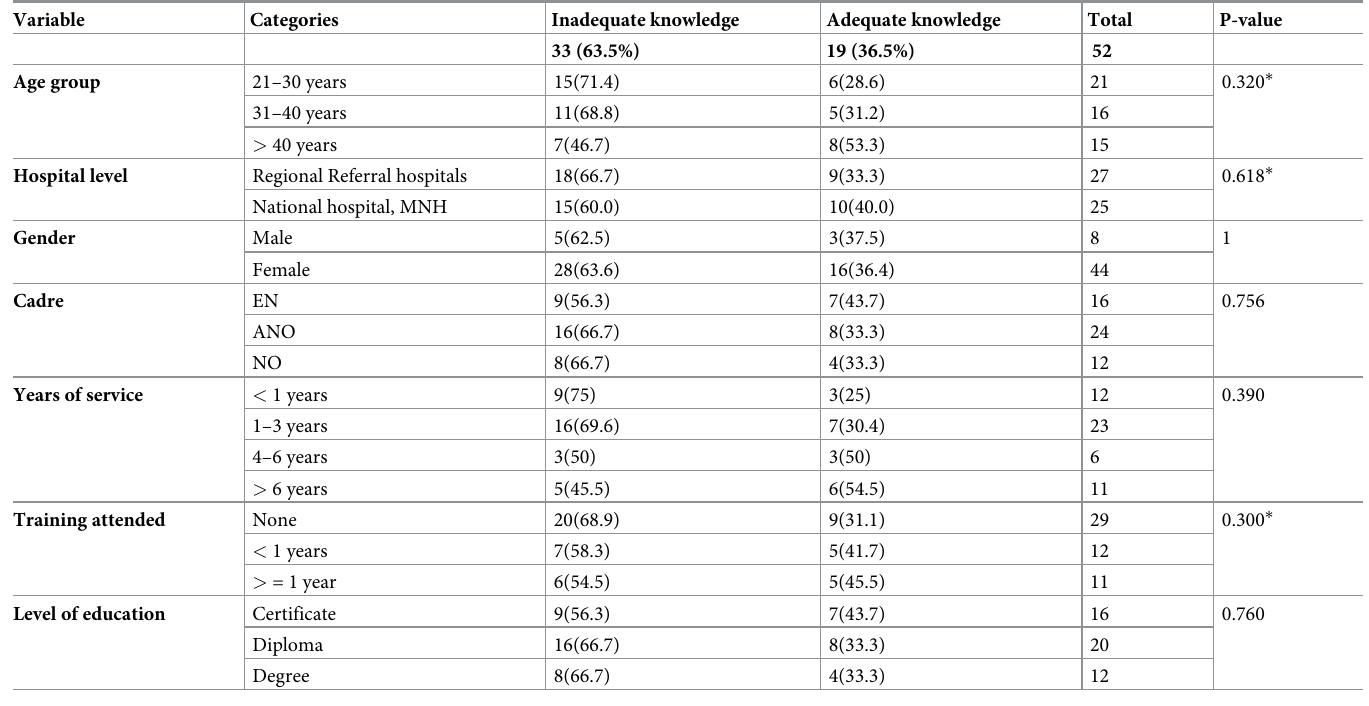
Table 3. Factors associated with nurse’s knowledge in special care and